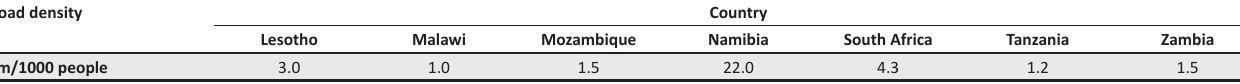
TABLE 3: Road density compared to population of SADC countries. Road density Country